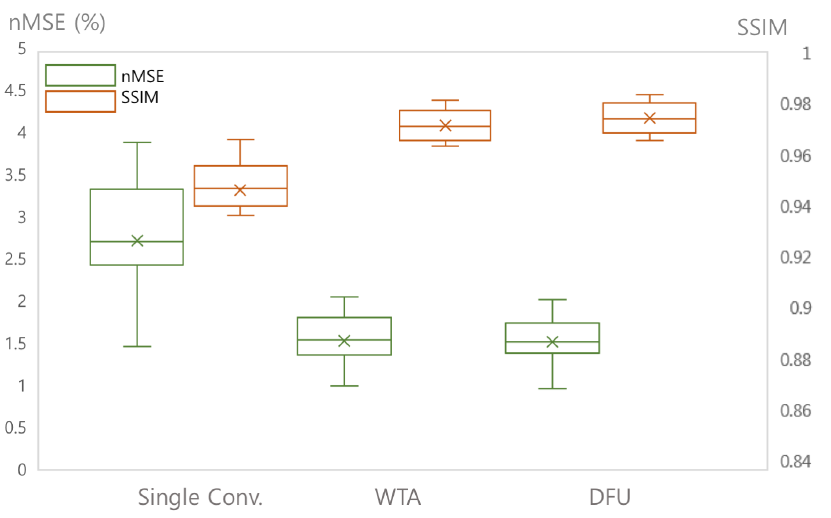
Figure 5. Quantitative analysis of three different refinement networks: single convolutional layer (Single Conv.), multiple convolutional layers with a deconvolutional layer (WTA), and